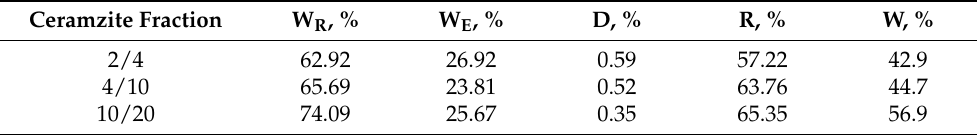
Table 1. Ceramzite sand indicator and sand soak information.